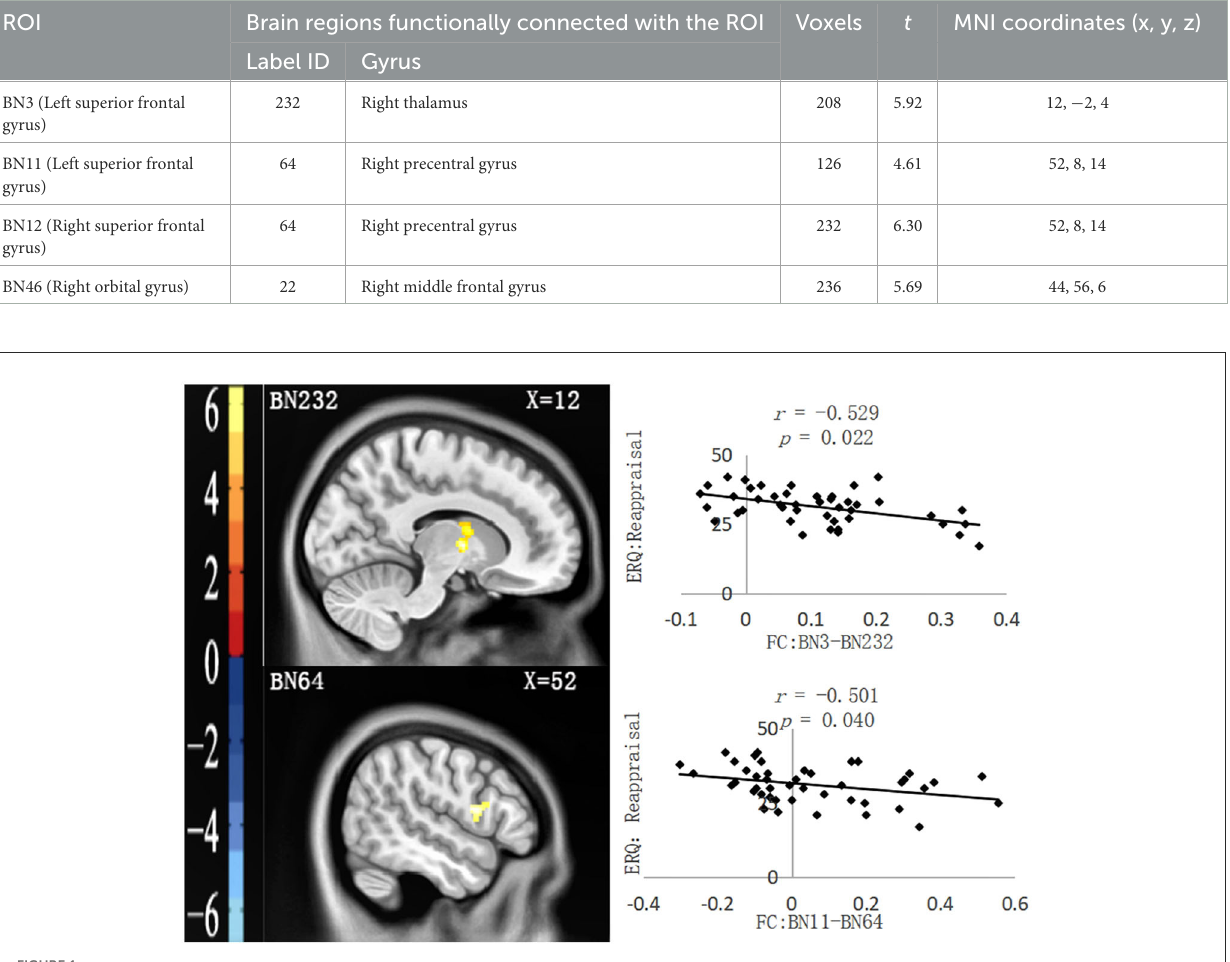
connection values were not significantly correlated with the ERQ suppression